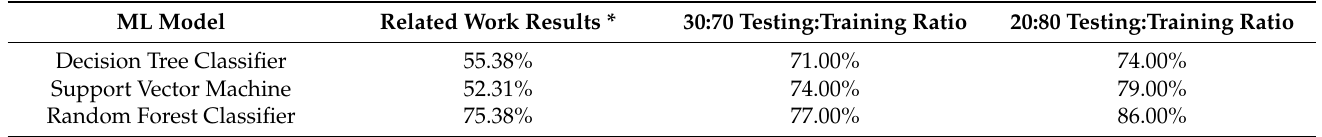
Table 3. Comparison of accuracy results between the related work [3] and this research without applying